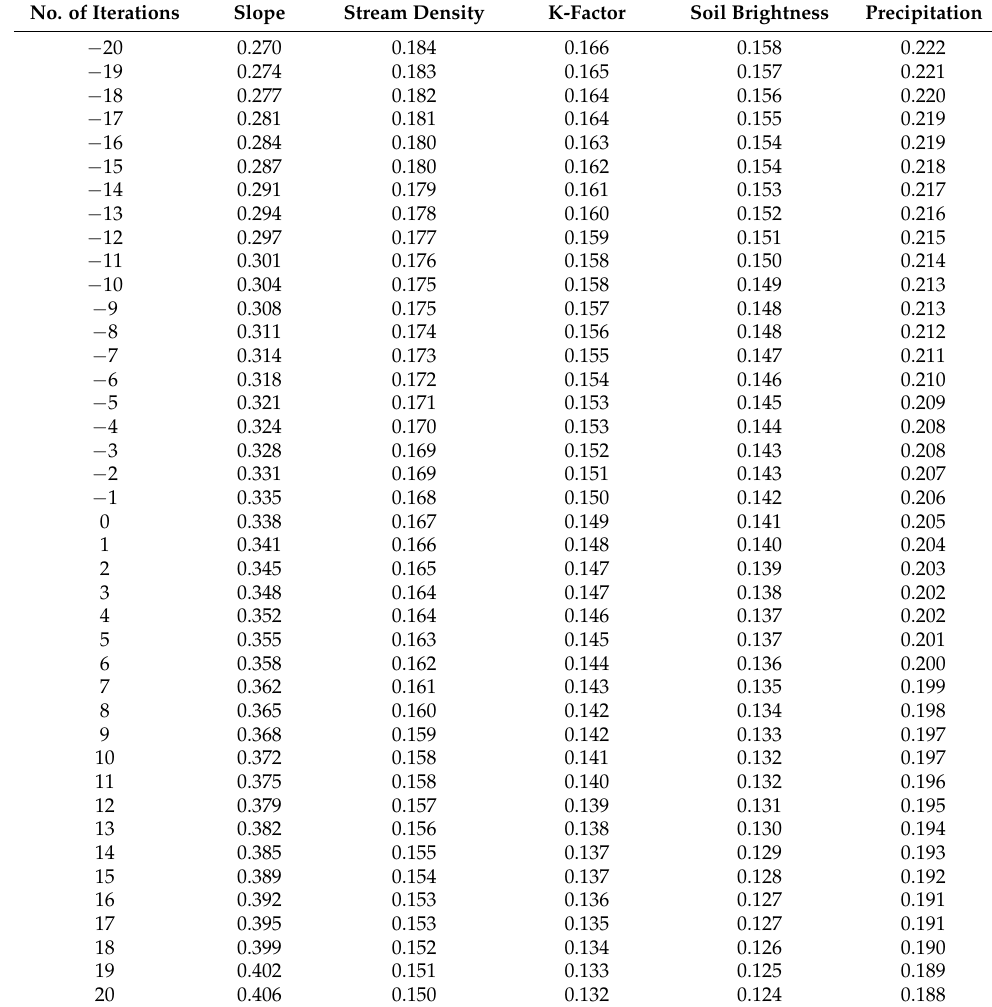
Table A1. Criteria weight variation example for 41 iterations in each data layer in the AHP